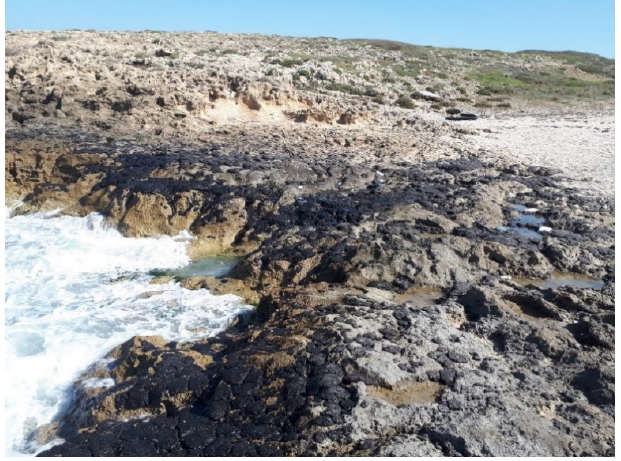
Figure 15. Tar pollution on the rocky coast of Habonim (south of Atlit) February 2021 (photograph by Dor Edelist). Modern coastal power plants pump huge amounts of seawater to cool their systems.